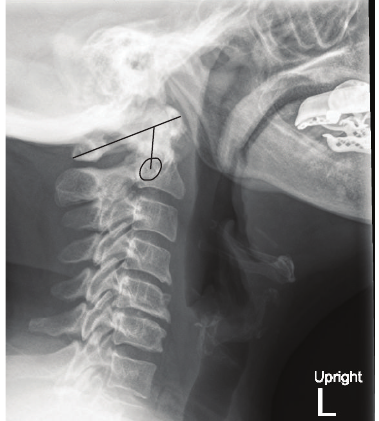
Figure 5: The Ranawat Criterion is the distance between the center of the C2 pedicle and the transverse axis of C1 measured along the axis of the odontoid process.